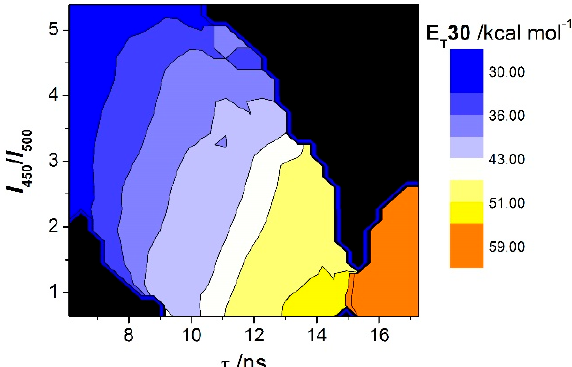
Figure 3. Multiparametric calibration of E T 30 values in a 3D space employing lifetime and time-gated intensity ratio I 450 / I 500 from dyes 1 – 3 .